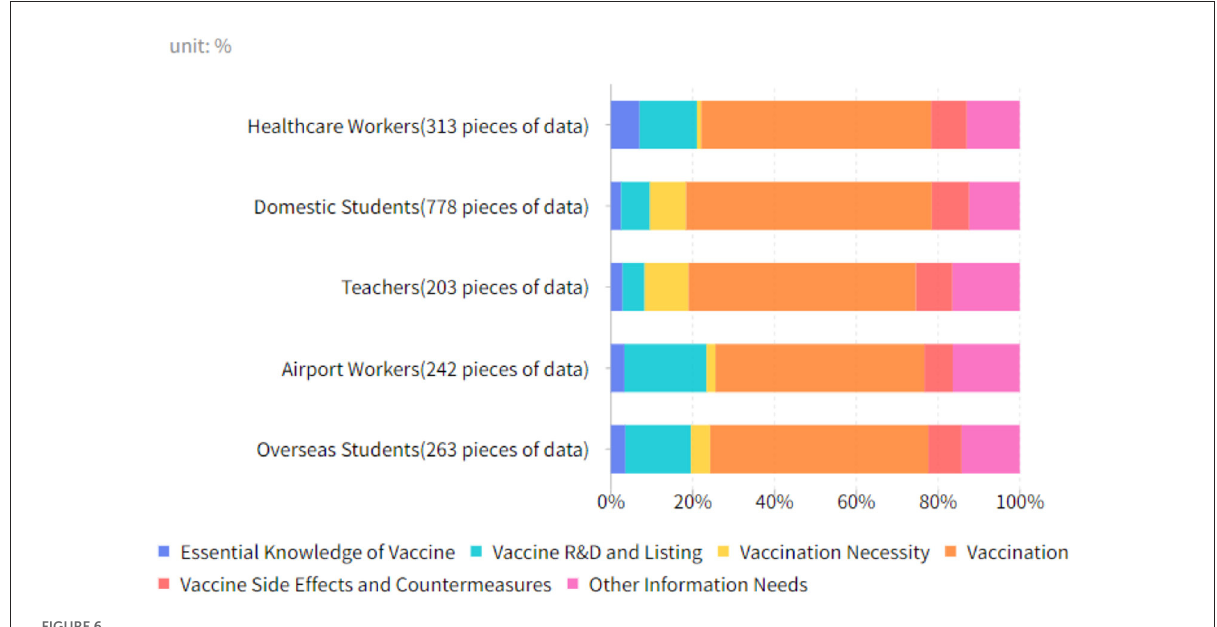
FIGURE6 COVID-19 vaccine information needs of different social groups during the